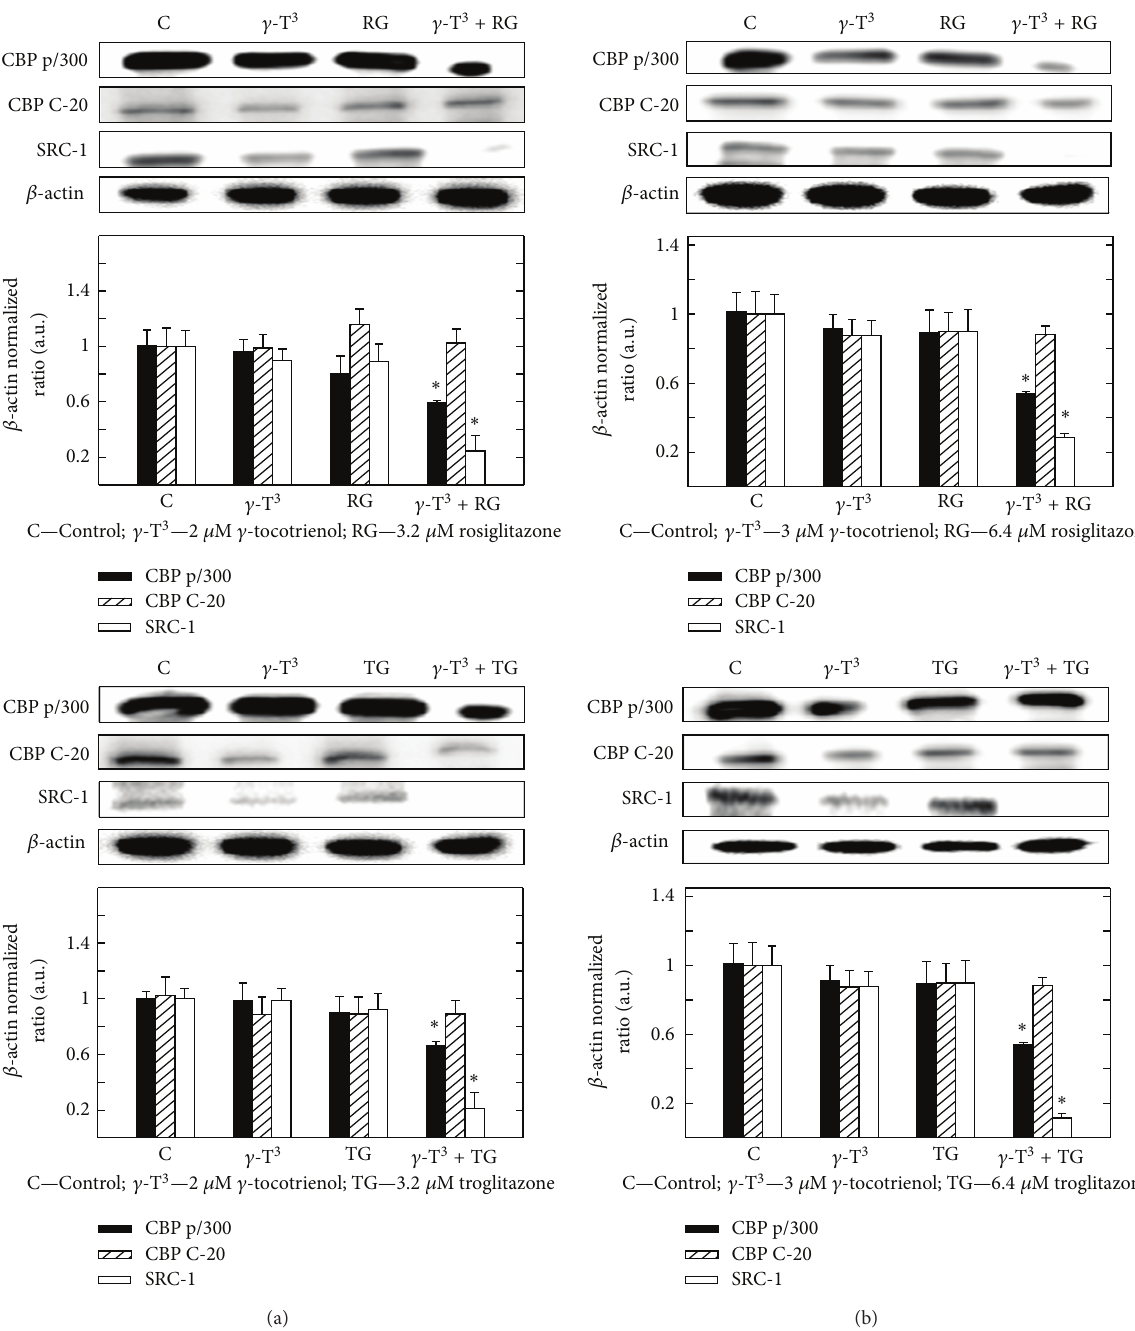
F 8: Western blot analysis of -tocotrienol and PPAR agonists (rosiglitazone and troglitazone) when used alone or in combination on the levels of CBP p/300, CBP C-20, and SRC-1 in (a) MCF-7 and (b) MDA-MB-231 human breast cancer cells. MCF-7 cells were initially platedat cells/100mmculturedishandtreated withcontrolortreatmentmediacontaining2 -tocotrienol,3.2 Mrosiglitazone,or 𝛾𝛾 𝛾𝛾 3.2 containing either 3 -tocotrienol or 6.4 M rosiglitazone or 6.4 M troglitazone alone or in combination. All cells were fed fresh treatment media every other day for a 4-day incubation period. Aerwards, whole cell lysates were from cell in each treatment group and prepared for 𝜇𝜇 subsequent separation by polyacrylamide gel electrophoresis (50 g/lane) followed by Western blot analysis. Scanning densitometric analysis 𝜇𝜇 was performed on all blots done in triplicate and the integrated optical density of each band was normalized with corresponding shown in bar graphs below their respective Western blot images. Vertical bars in the graph indicate the normalized integrated optical density 𝜇𝜇 as compared with vehicle-treated of bands visualized in each lane SEM. ∗ 𝑃𝑃 𝑃 0𝑃0𝑃 ±